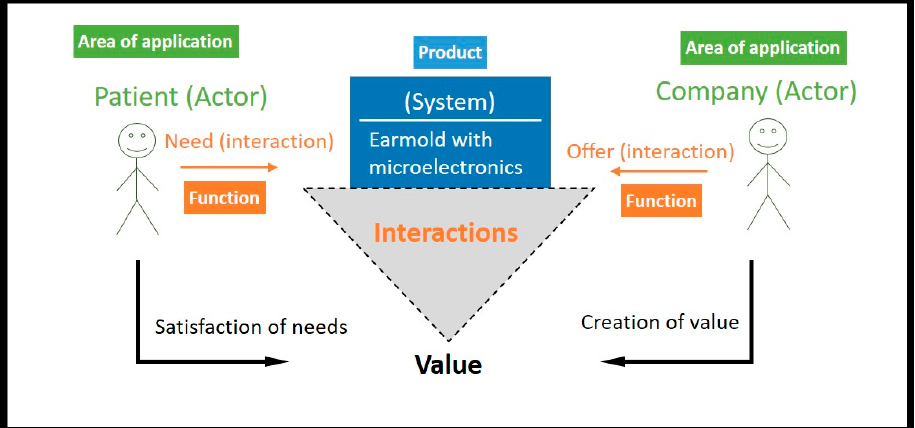
Figure 2. Derivation of specific attributes to categorize the use cases of iMMS. These are “area of application”, “product” and “function”.